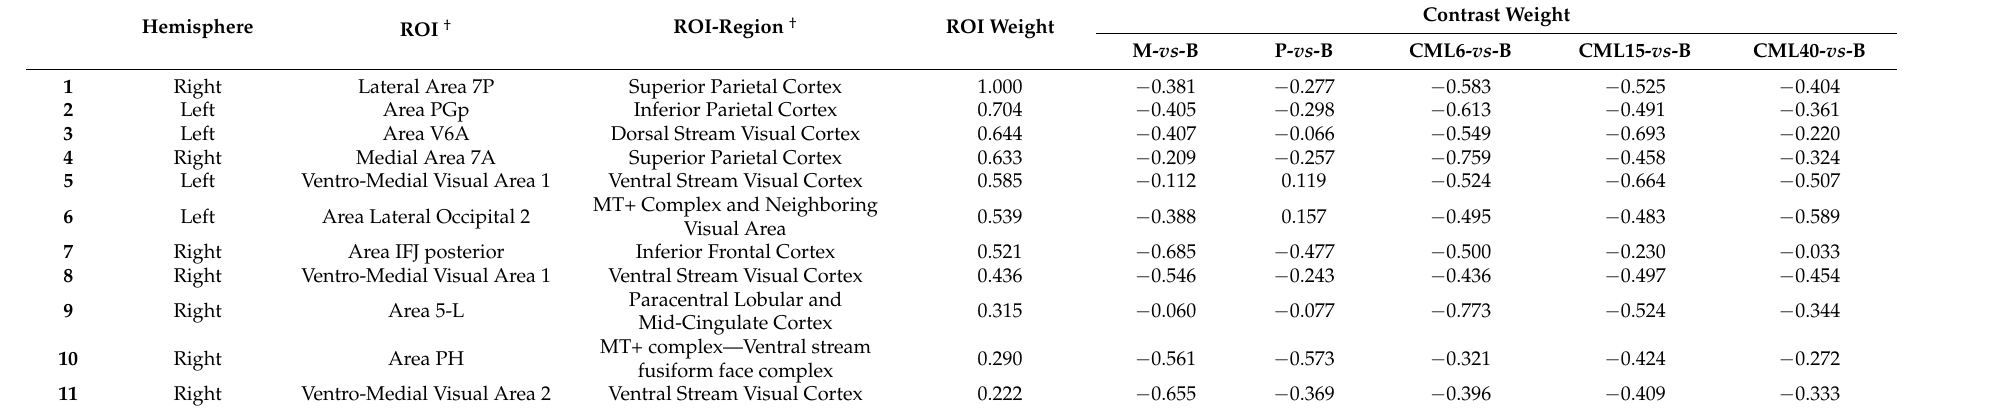
Table 2. List of the ROIs with the highest performance.